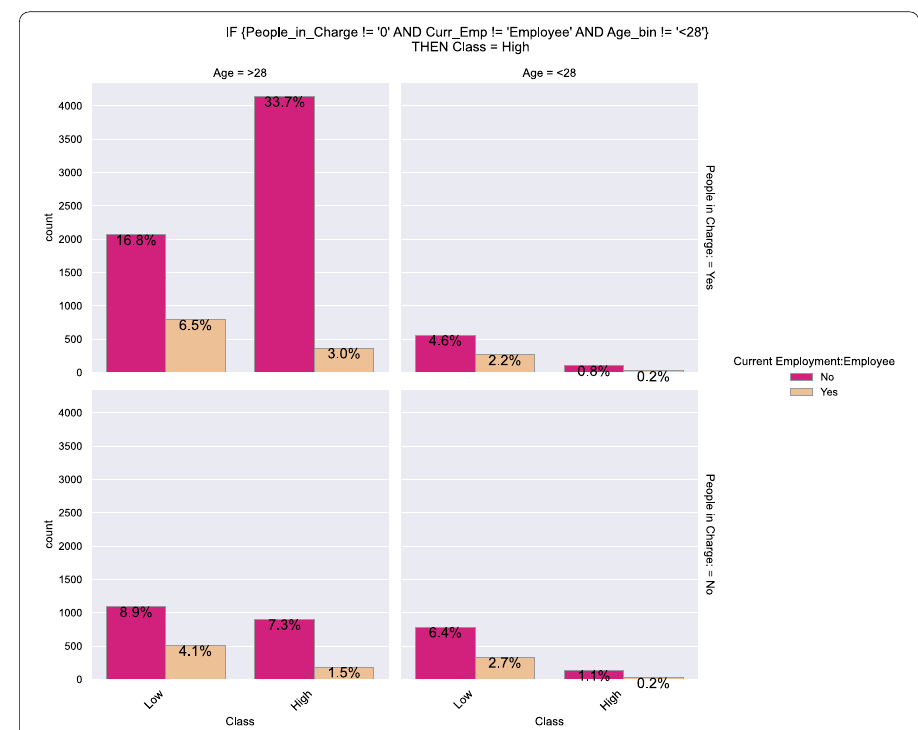
Fig. 20 Visualization of the third contrast pattern of People in Charge, Current Employment, and binarization of Age variables in bar plot count